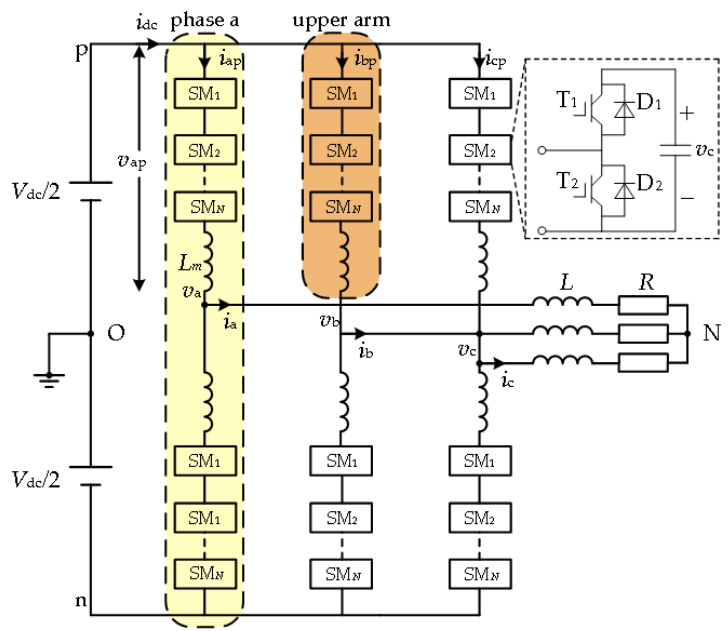
Figure 1. The topology of a modular multilevel converter. Table 1. The operating state of